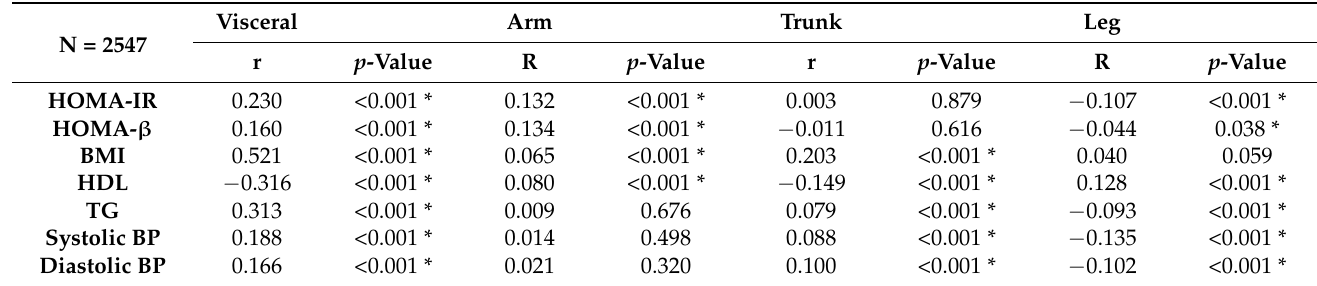
Table 4. Associations between regional adiposity and metabolic characteristics in the total population.